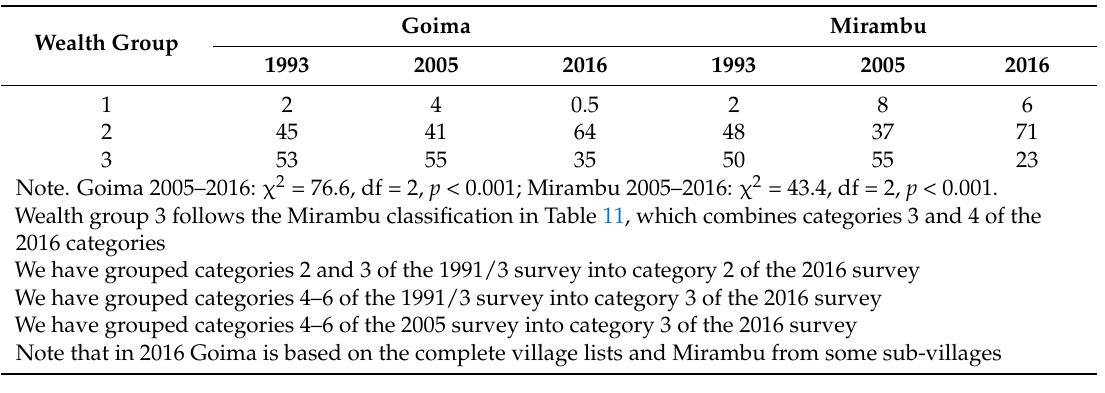
Table 10. Changing Wealth Profiles—proportion of families in different wealth